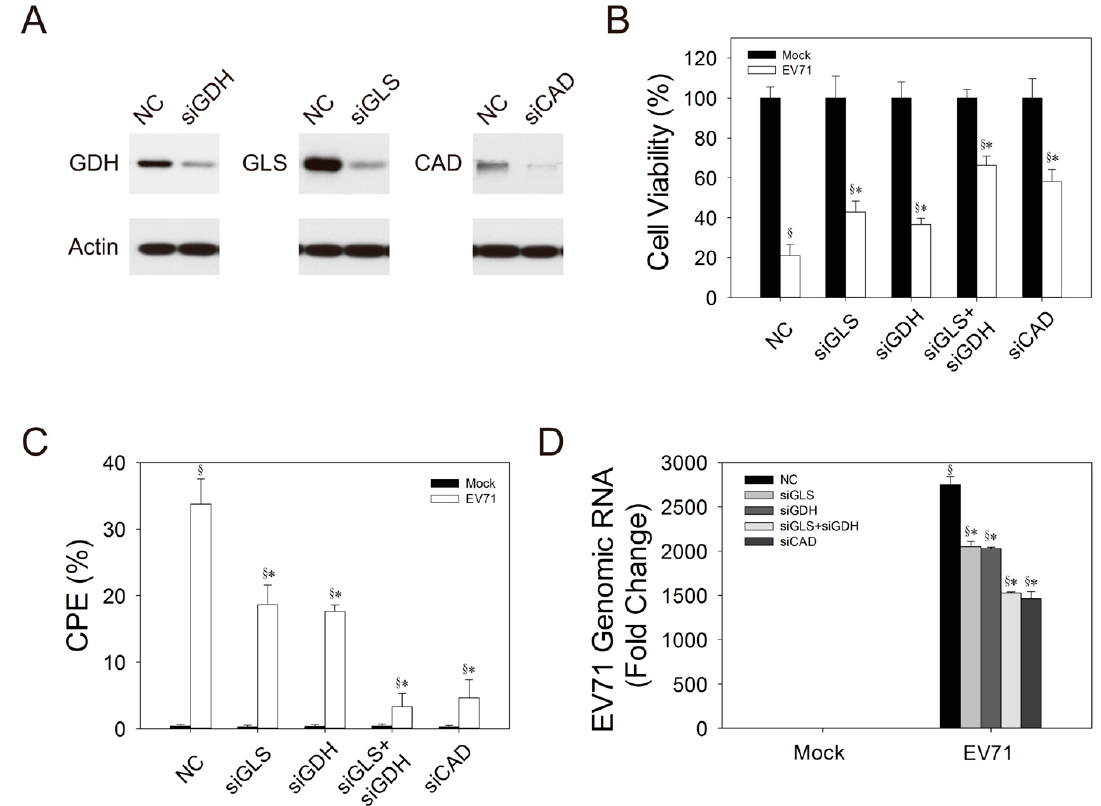
Figure 7. GLS, GDH, and CAD are essential to viral replication. ( A ) Vero cells were transfected with NC siRNA, siGDH, siGLS and siCAD, and 48 h after transfection, the cells were analyzed for expression of GDH, GLS and CAD by western blotting. An equal amount of the lysate of each transfectant was analyzed for expression of actin by western blotting. A representative result of three experiments is shown. ( B – D ) Vero cells were transfected with NC siRNA, siGDH, siGLS or siCAD for 48 h, and the transfected cells were mock- (solid bar) or infected (empty bar) with virus at MOI of 1.25. After 48 h, the infected cells were analyzed for cell viability ( B ) and the percentage of CPE ( C ). The cell viability data are expressed as percentage relative to those of mock-infected cells. Data are mean ± SD of six experiments. ( D ) Total RNA was extracted from mock- (Mock) or infected ( EV71 ) cells for determination of viral genomic RNA. The result is expressed as fold change relative to that at 0 h p.i. Data are mean ± SD of six experiments. § p < 0.05, significant di ff erence from mock-infected cells; * p < 0.05, significant di ff erence from NC siRNA-transfected